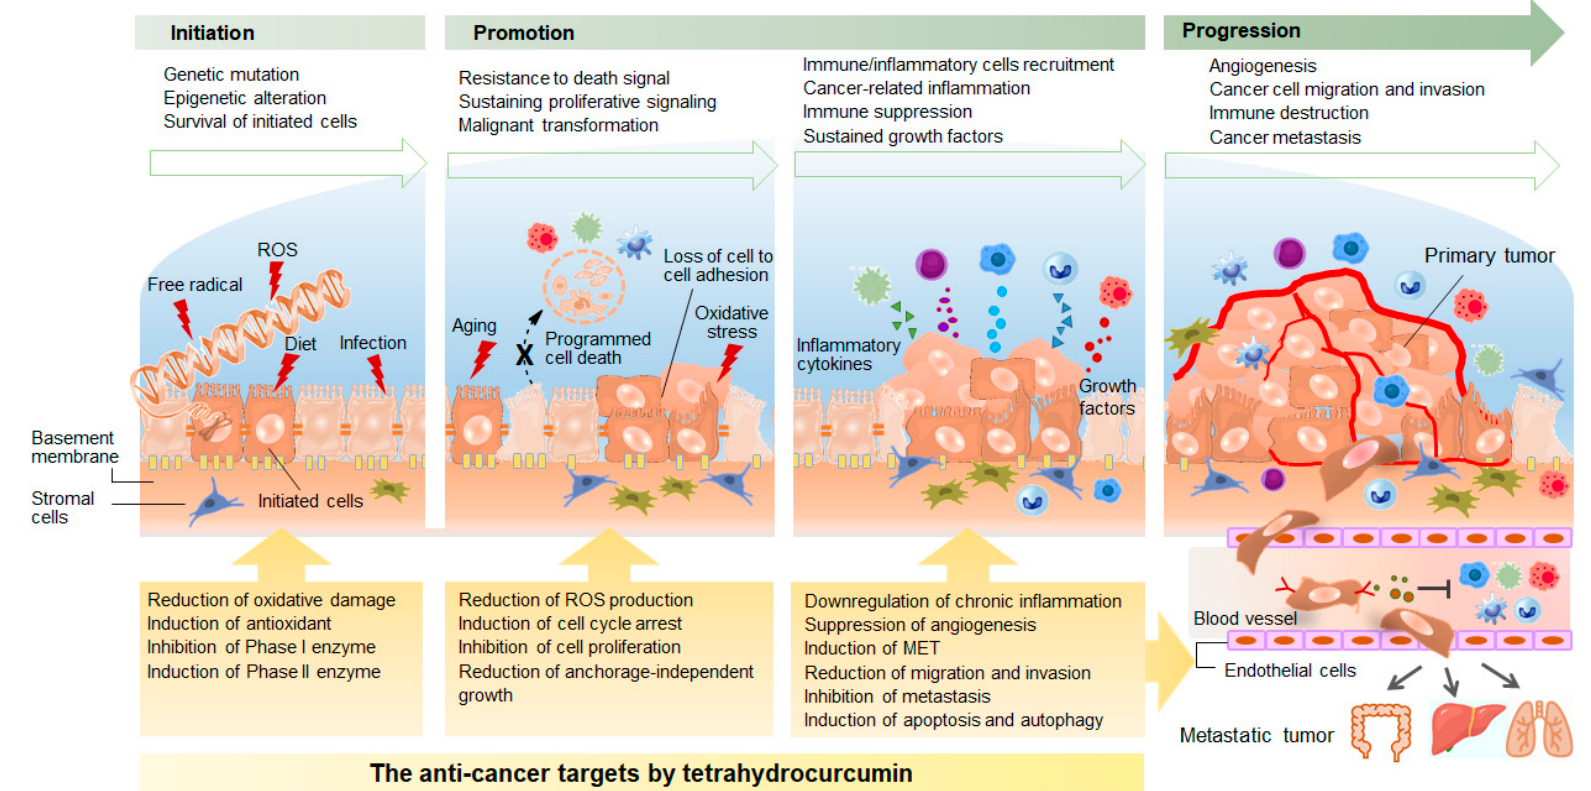
Figure 2. Mechanisms underlying multi-step tumorigenesis and the mechanism by which tetrahydrocurcumin exerts its anticancer action. ROS, reactive oxygen species; MET, mesenchymal-epithelial transition